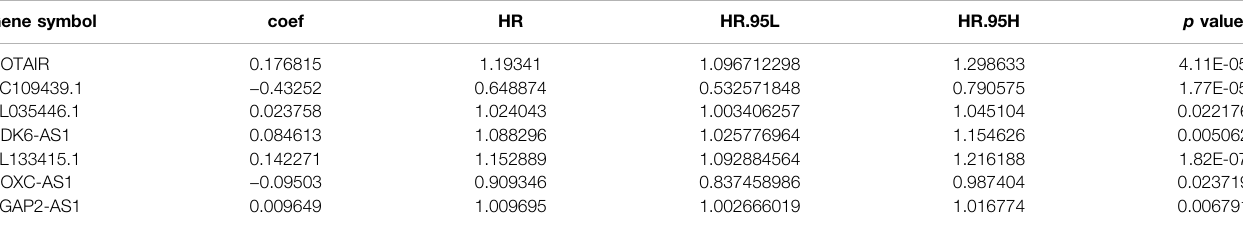
TABLE 2 | Multivariate Cox regression analyses of the genome instability-related lncRNAs associated with overall survival in Glioma. Gene symbol coef HR